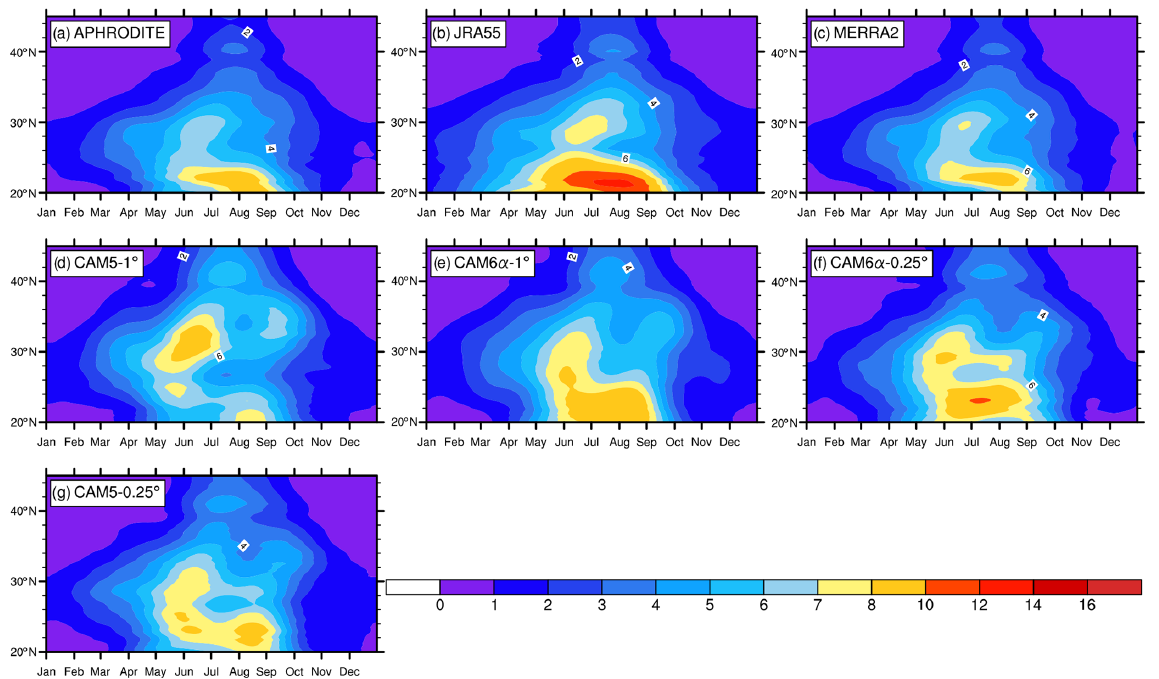
Figure 10. Annual cycle of the regional mean precipitation rate (mmd − 1 ) for 1980–2004 within a part of Asia (between 100 and 125 ◦ E): (a) APHRODITE, (b) JRA55, (c) MERRA2, (d) CAM5-1 ◦ , (e) CAM6 α -1 ◦ , (f) CAM6 α -0.25 ◦ and (g) CAM5-0.25 ◦